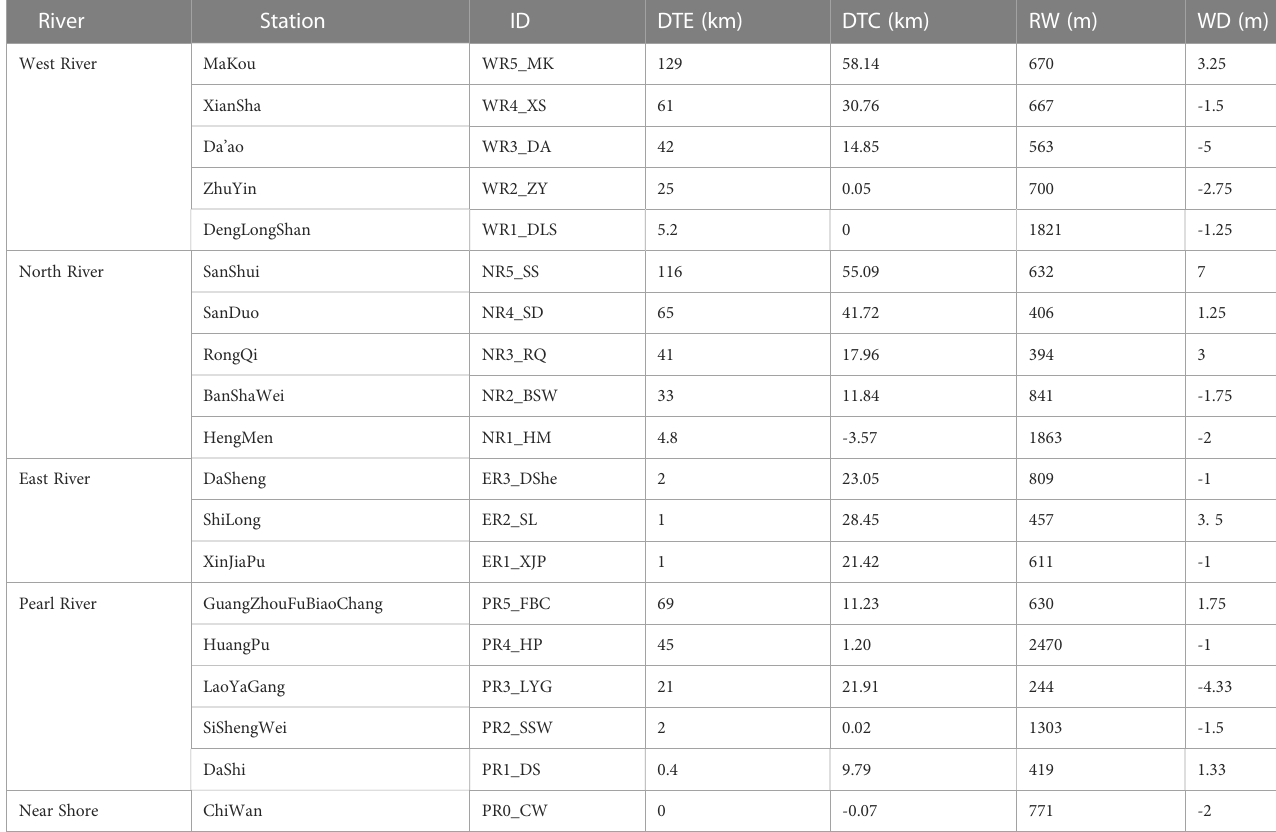
TABLE 1 The morphological characteristics at hydrological stations.